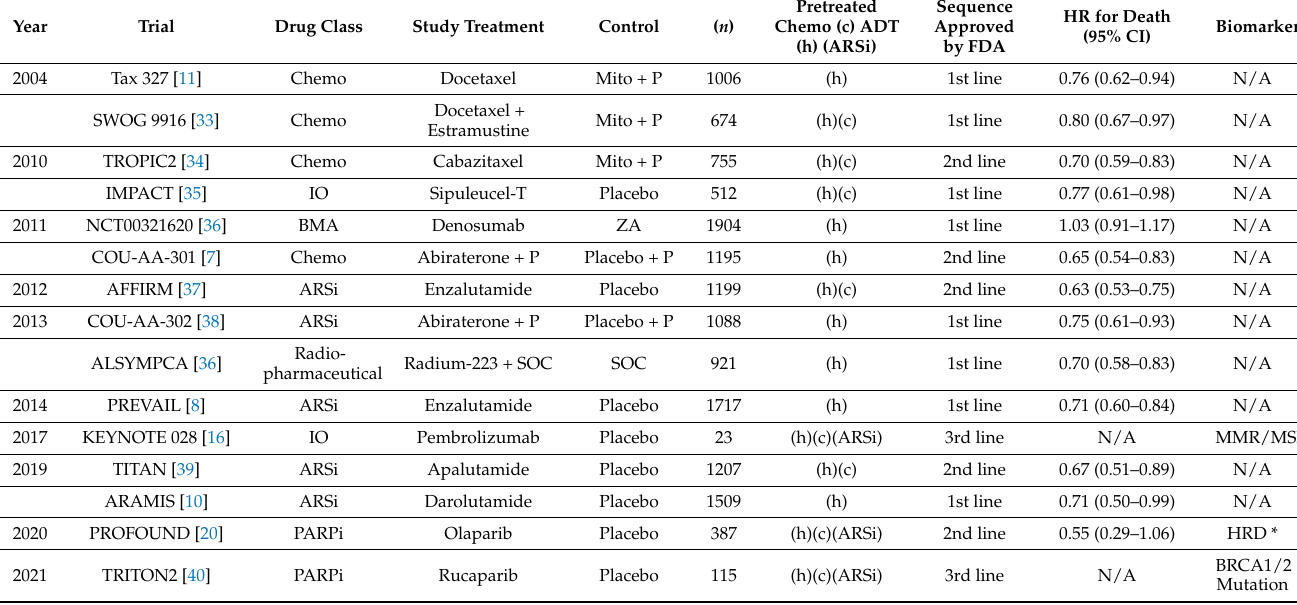
Table 1. Practice Changing Trials and Drug Approvals for